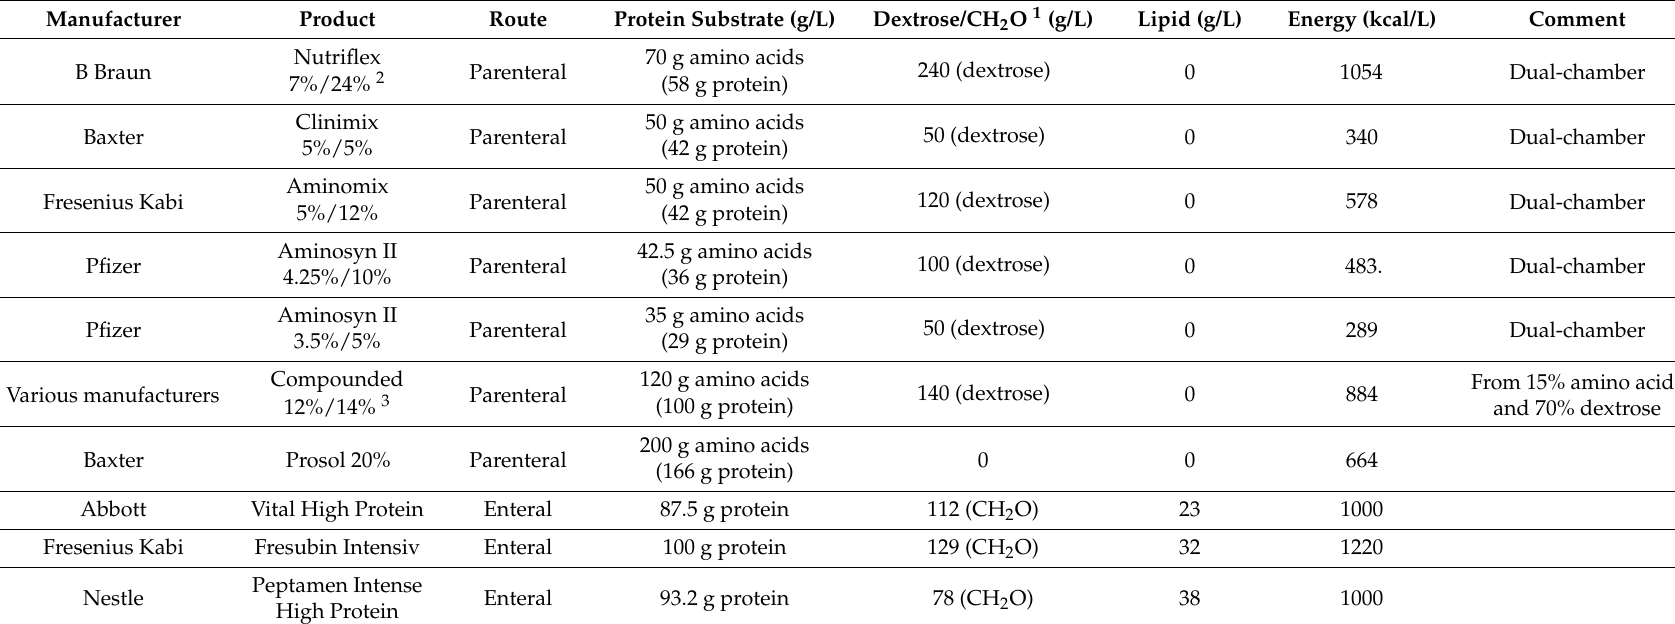
Table 1. Protein and energy content of some high-protein energy-restricted parenteral and enteral nutrition